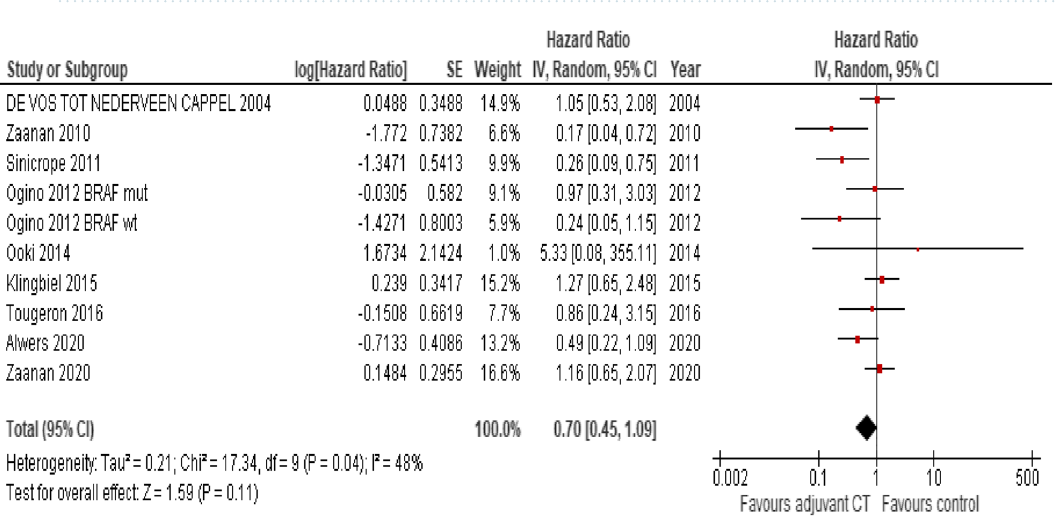
Figure 3. Forest plot for disease-free survival in MSI-H treated with adjuvant chemotherapy (polychemotherapy or single agent) vs control arms (single agent or surgery